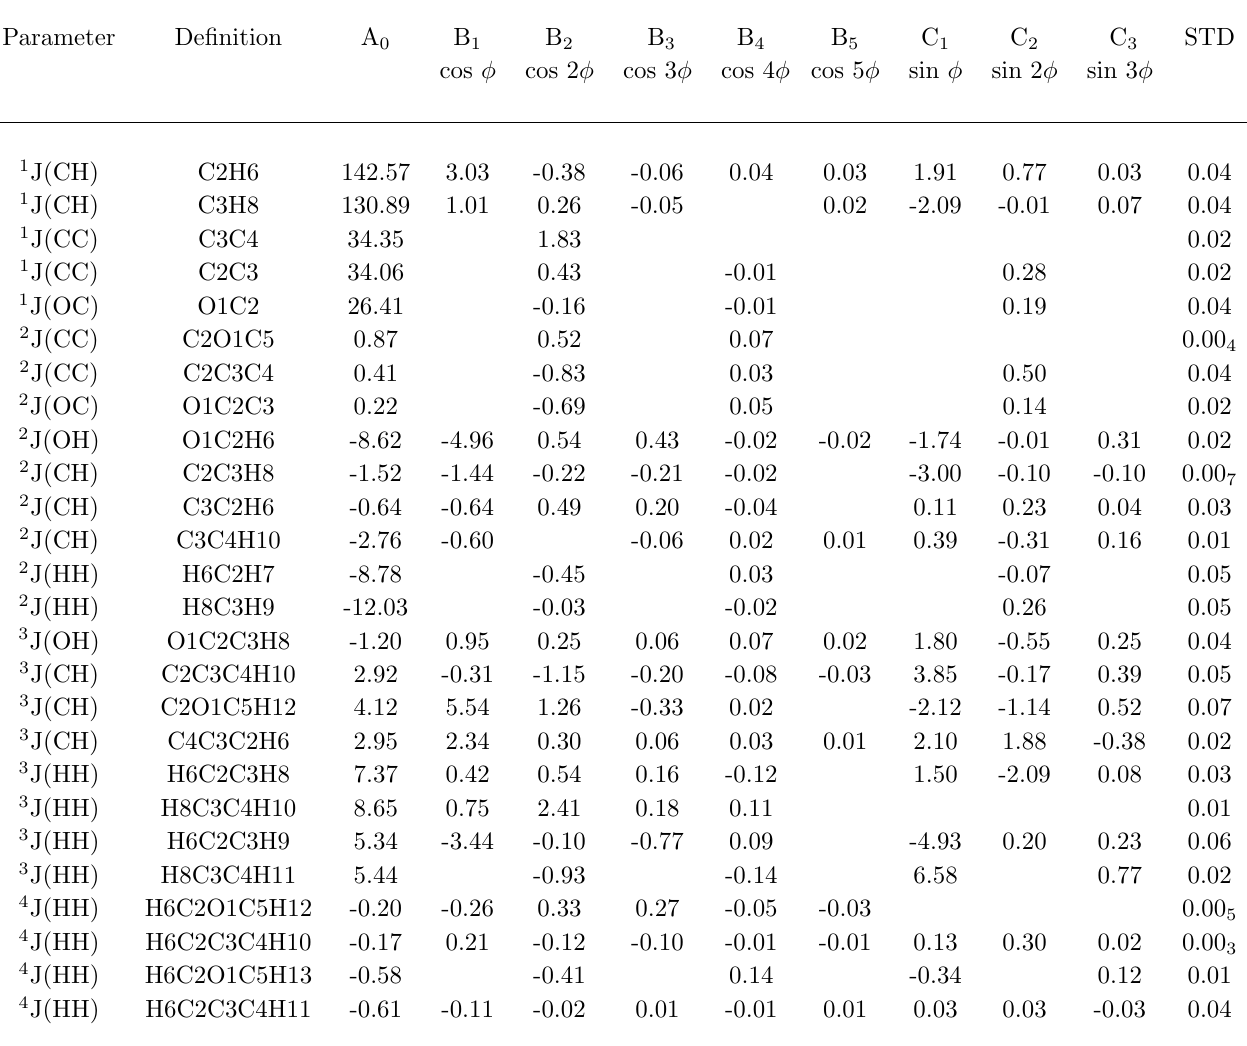
Table 4. Fourier expansion coefficients for the SSCCs of THF. a